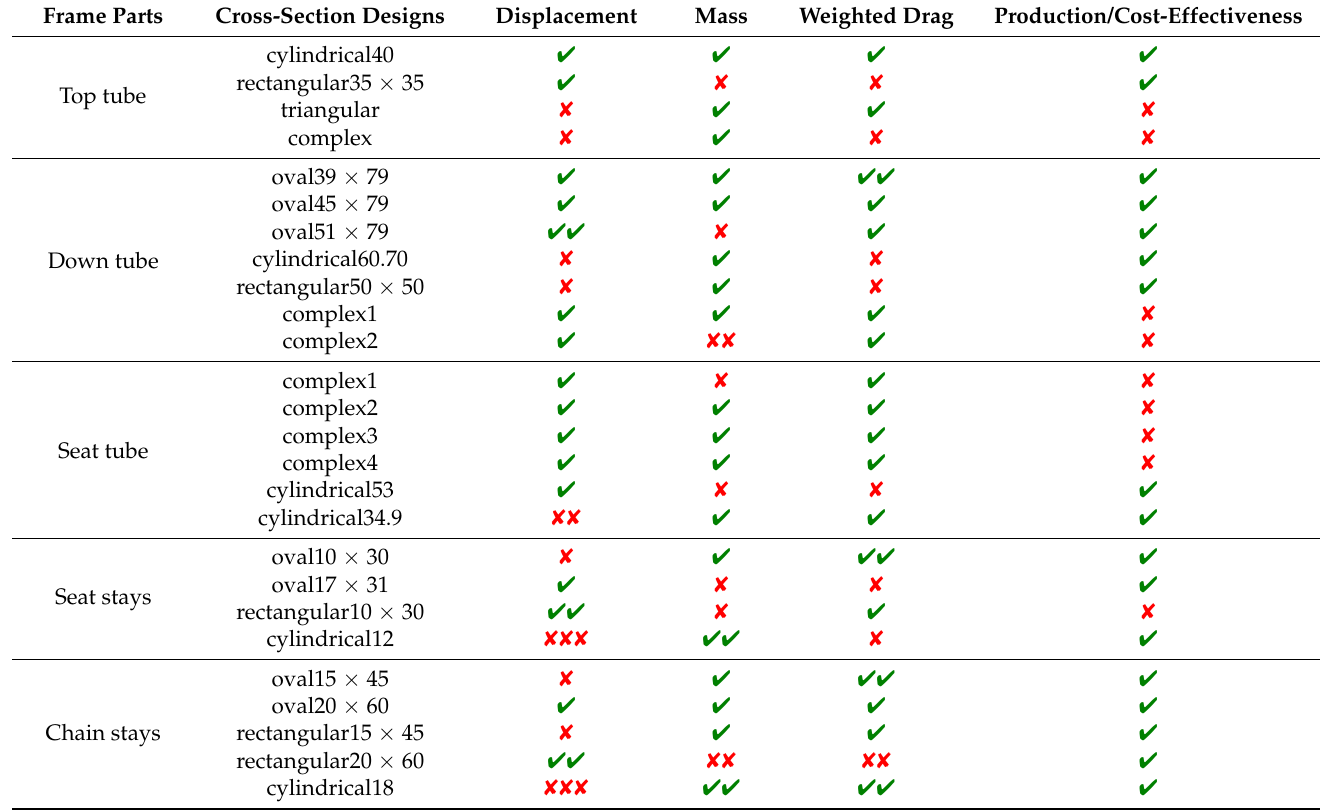
Figure 30. Weighted drag force on chain stay cross-sections. Table 15. Evaluation of each